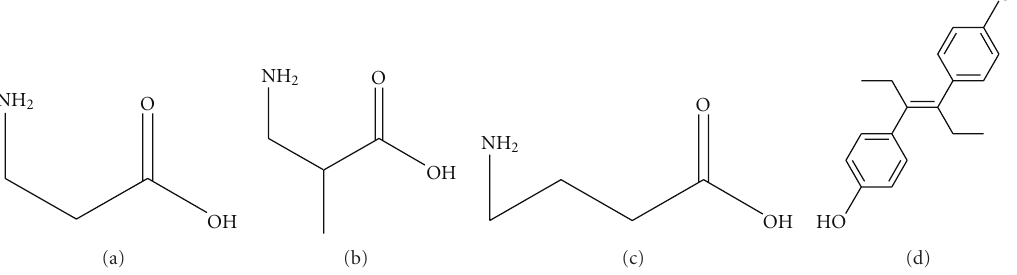
Figure 2: Structures of physiologically active substances which can activate MRGPRD: (a) beta-alanine ( β Ala), (b) beta-aminoisobutyric acid ( β AIBA), (c) gamma-aminobutyric acid (GABA), and (d) diethylstilbestrol (DES).